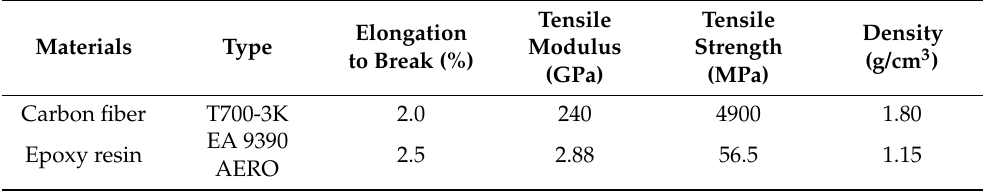
Table 1. Material properties of carbon fibers and epoxy resin.